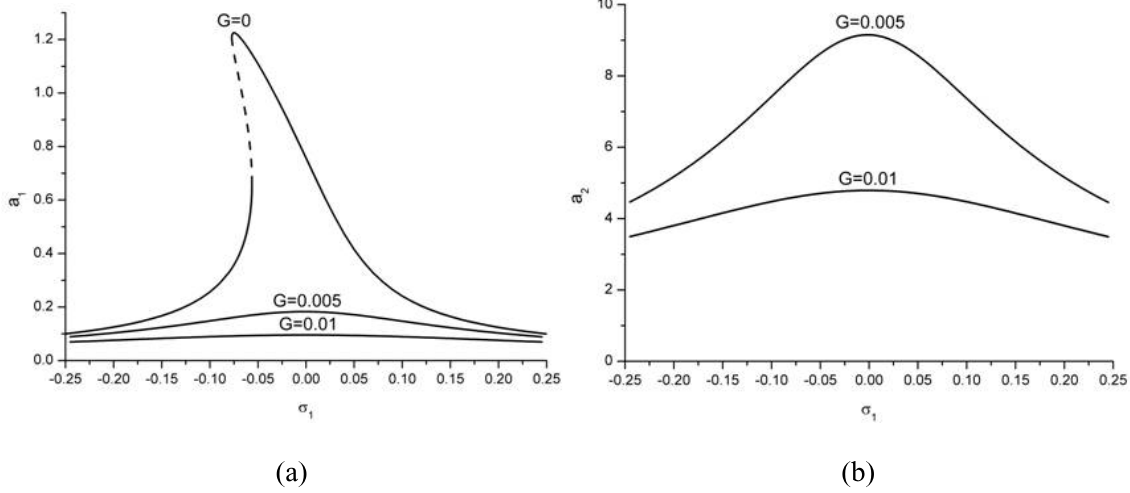
Fig. 3. Effect of varying the feedback gain on the frequency-response curves of (a) the plant and (b) the absorber when f = 0 . 025 , ζ = 0 . 01 and ν 2 = 0